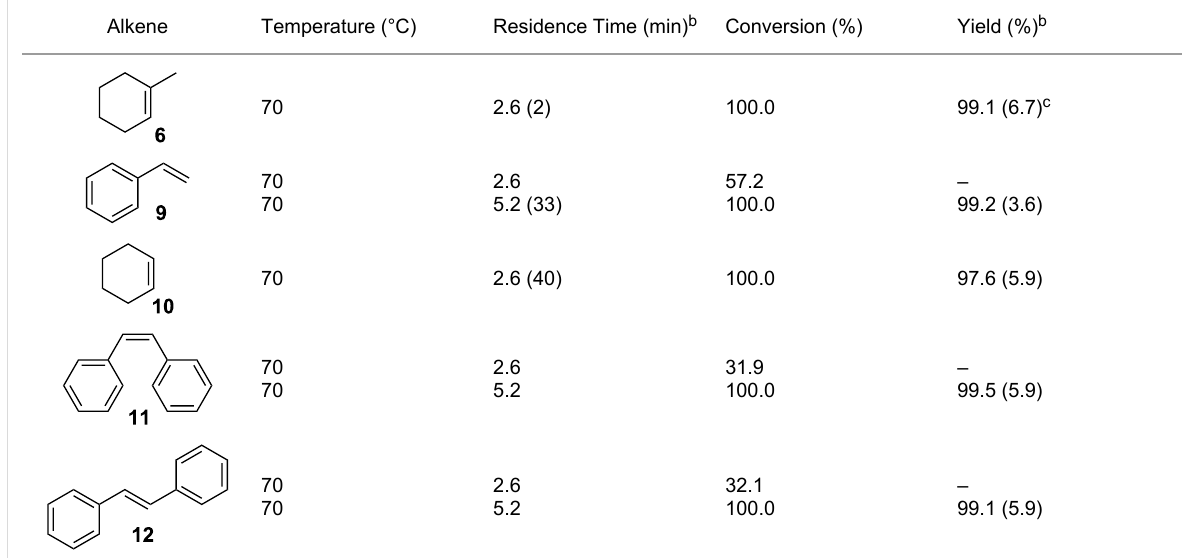
Table 1: Summary of the reaction conditions employed for the lipase-mediated epoxidation of an array of alkenes under continuous